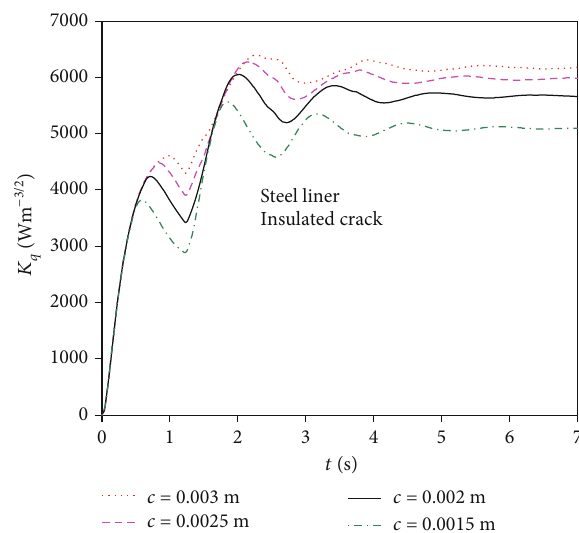
Figure 6: E ff ect of liner material on the HFIF history.